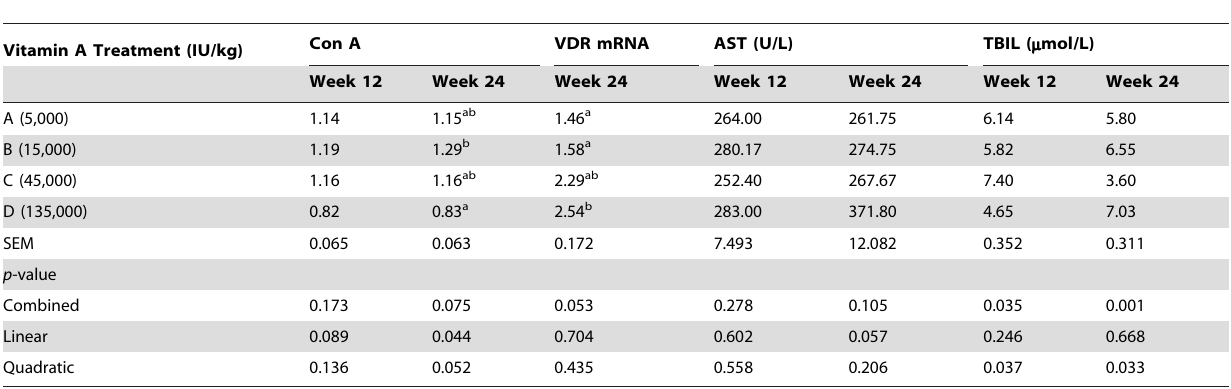
Table 9. Peripheral blood lymphocyte proliferation, liver functions, and mRNA expression of vitamin D receptor (VDR).